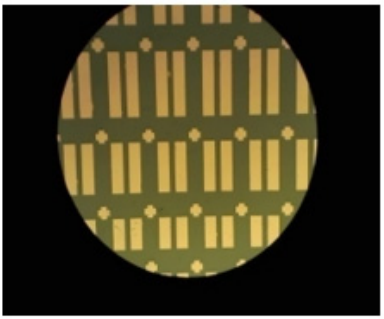
Figure 2. A micrograph of un-patterned a -IGZO TFT devices with different channel sizes.